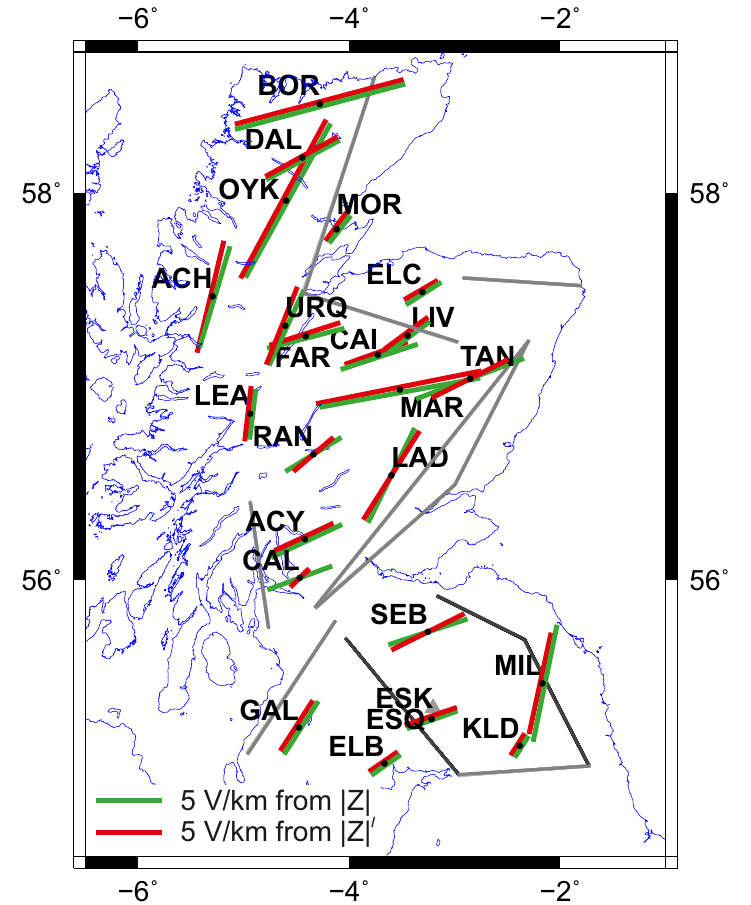
Fig. 8. Vector representation of the maximum peak-to-peak, Halloween storm-time, electric fi eld magnitudes at 21:20 UT on 30th October 2003. There is an inherent 90 (cid:3) ambiguity in these directions. However, they mostly do not correspond with the directions of coastlines outlined in blue. Light and dark grey lines are the longest (>50 km) 12 high-voltage – 275 kV and 400 kV, respectively – transmission lines in the region (Viljanen et al.,